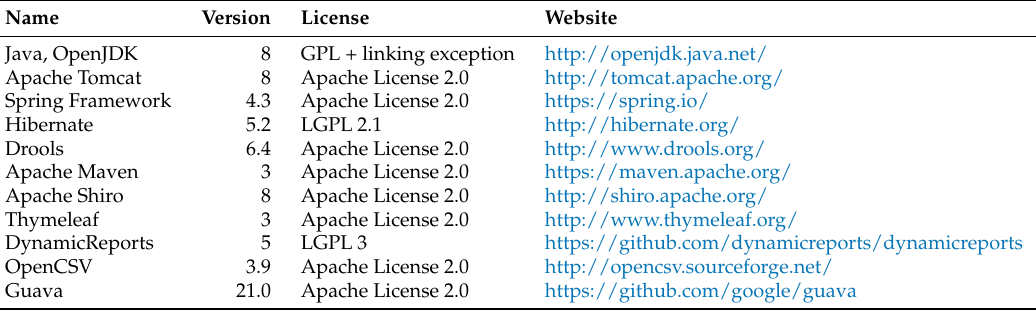
Table A1. Direct dependencies of the NanoDefiner e-tool. All websites accessed